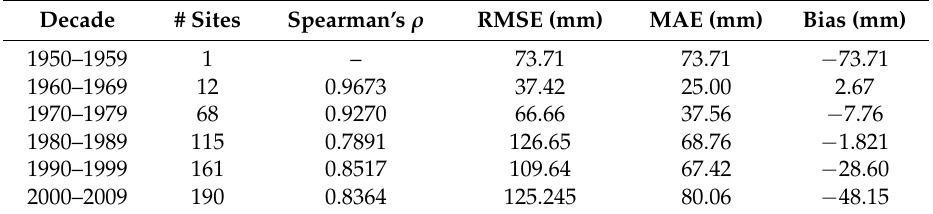
Table 3. Comparison of cumulative April 1 SWE at SNOTEL and snowcourse stations to CRU 3.1